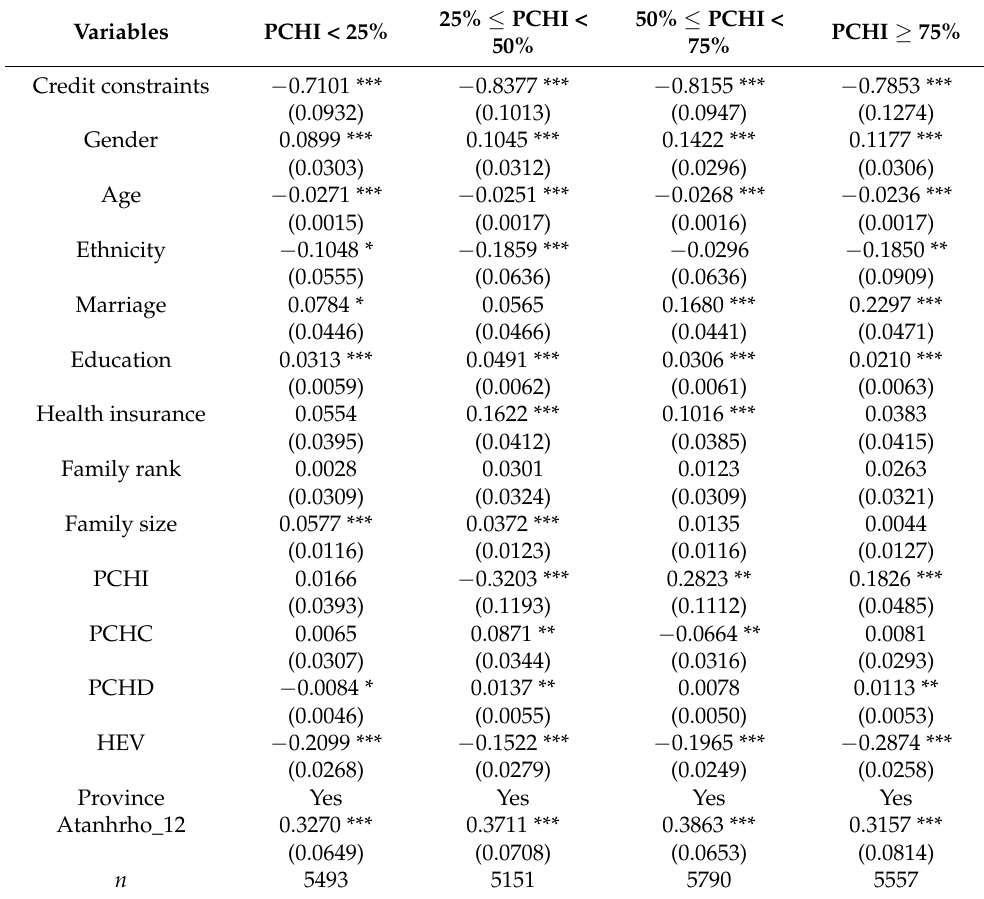
Table 5. Impact of formal credit constraints on rural residents’ self-rated health on different income groups as obtained from using IV-ordered probit